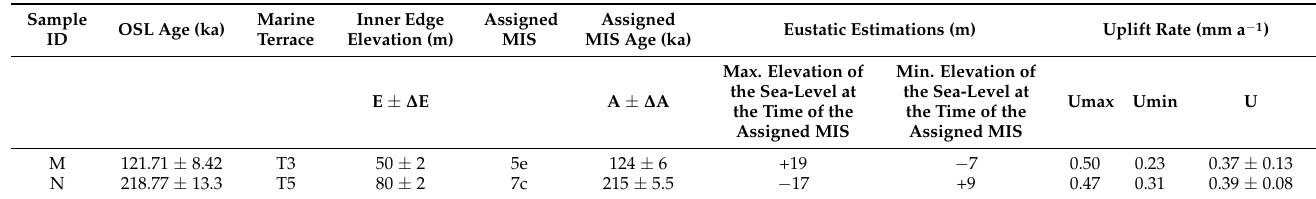
Table 2. Calculation of uplift rates of the inner edges of terraces T3 and T5 along Profiles 1 and 3 at the locations where the samples for OSL dating were collected. For the calculations of the errors associated with the position of the sea-level at the time of the formation of the terraces, we used the sea-level curve of Waelbroeck et al. [25], while for the uncertainties due to the duration of the MIS, we adopted the time boundaries of the MIS highstands from Lisiecki and Raymo